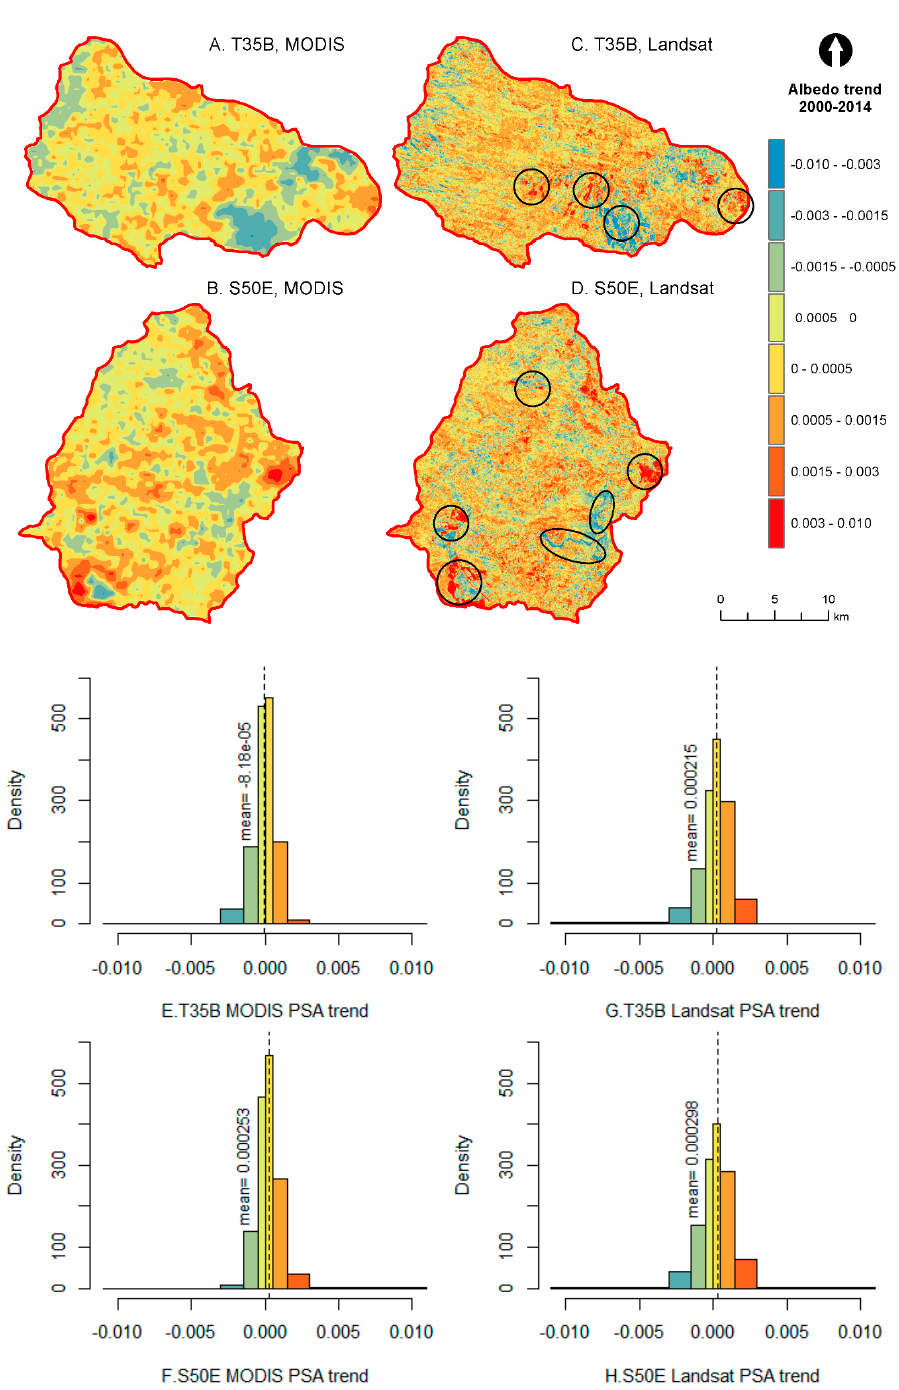
Figure 3. Peak season albedo ( p SA) trend ( top ) and histogram of trend ( bottom ) measured with MODIS and Landsat for T35B and S50E between